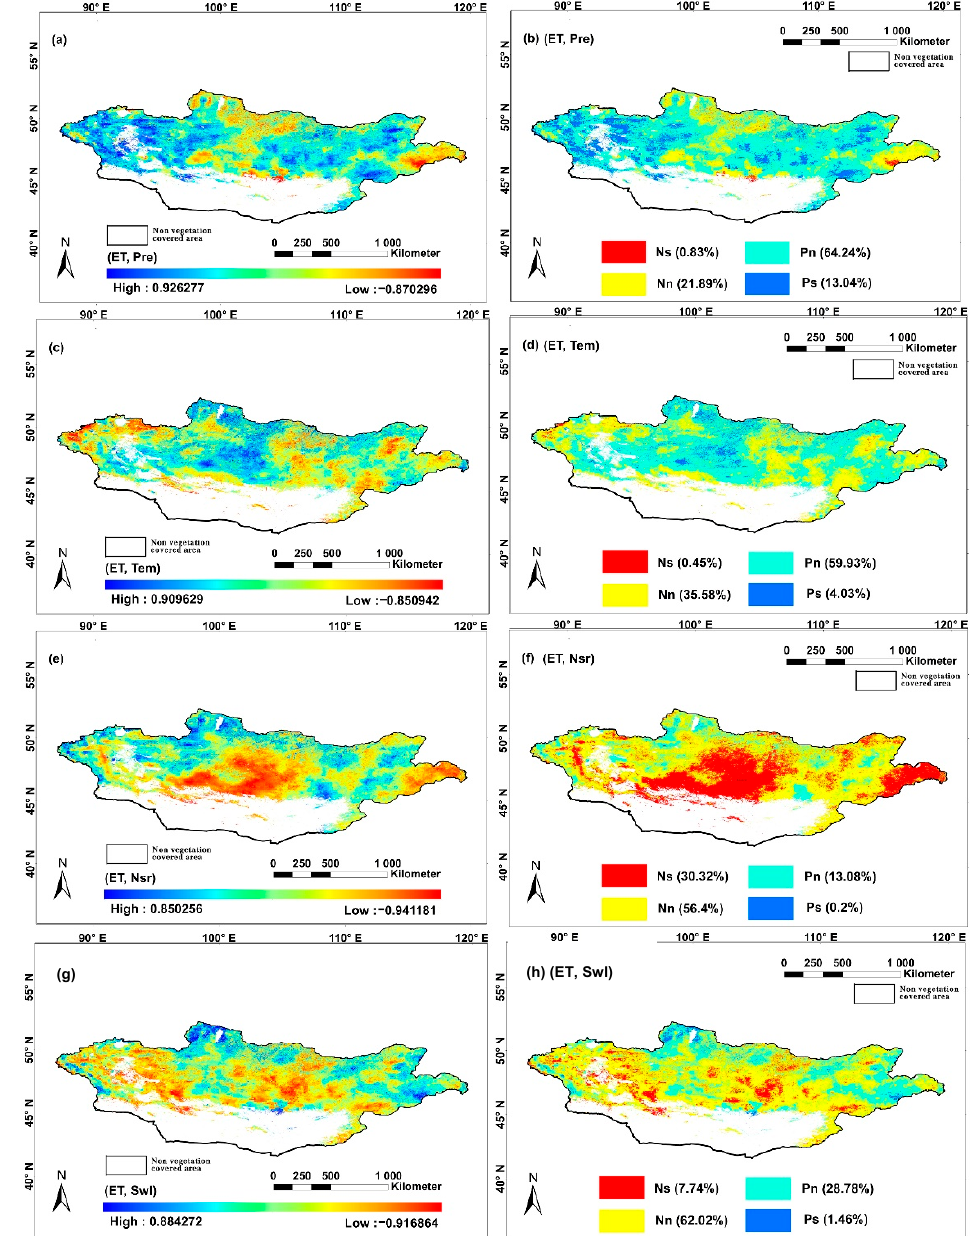
Figure 7. Spatial distributions of the partial correlation coefficients between climate factors and ET in the growing season from 2001 to 2020: ( a , b ) Pre, ( c , d ) Tem, ( e , f ) Nsr, ( g , h ) Swl, and ( i,j ) NDVI. The percentages of Ns (significant negative correlation), Nn (nonsignificant negative correlation), Pn (nonsignificant positive correlation), and Ps (significant negative correlation) values are